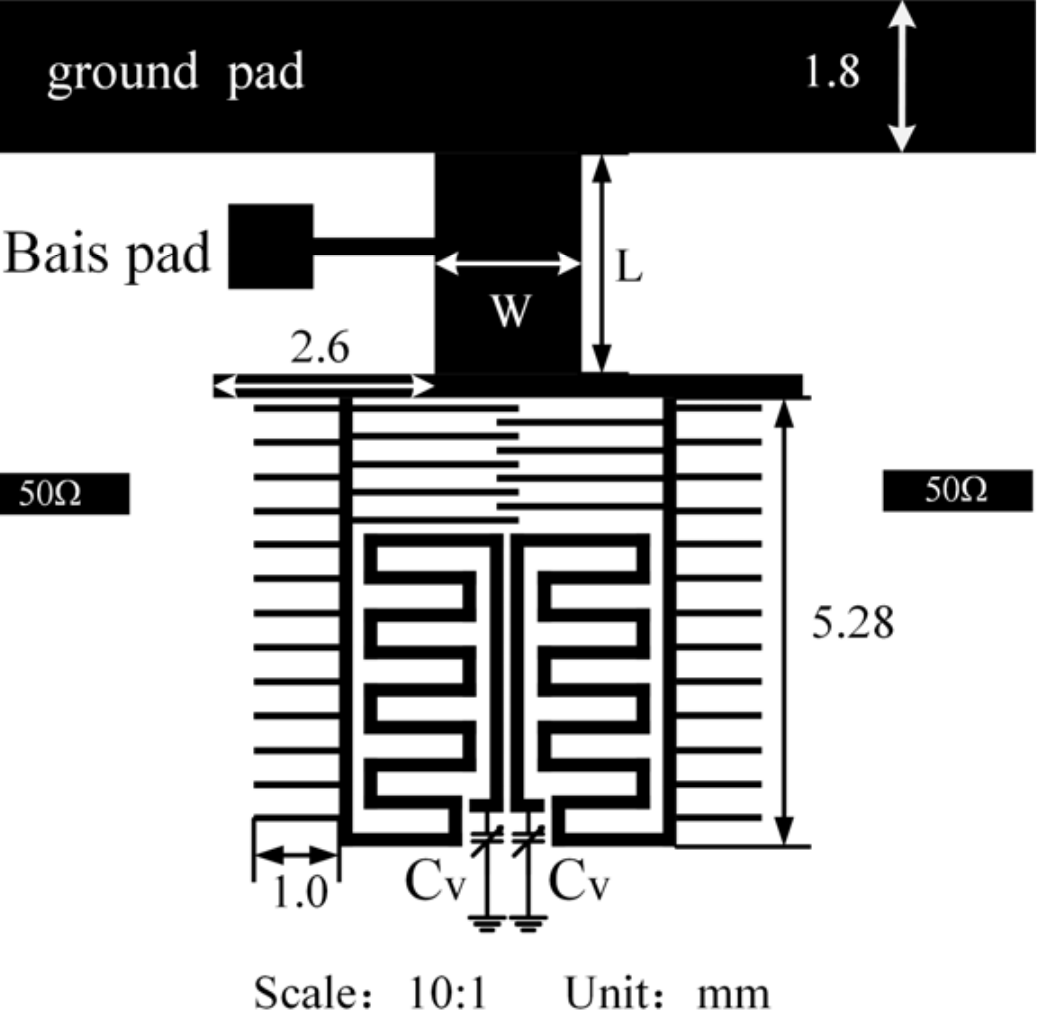
Figure 1. The structure of the proposed tunable resonator.